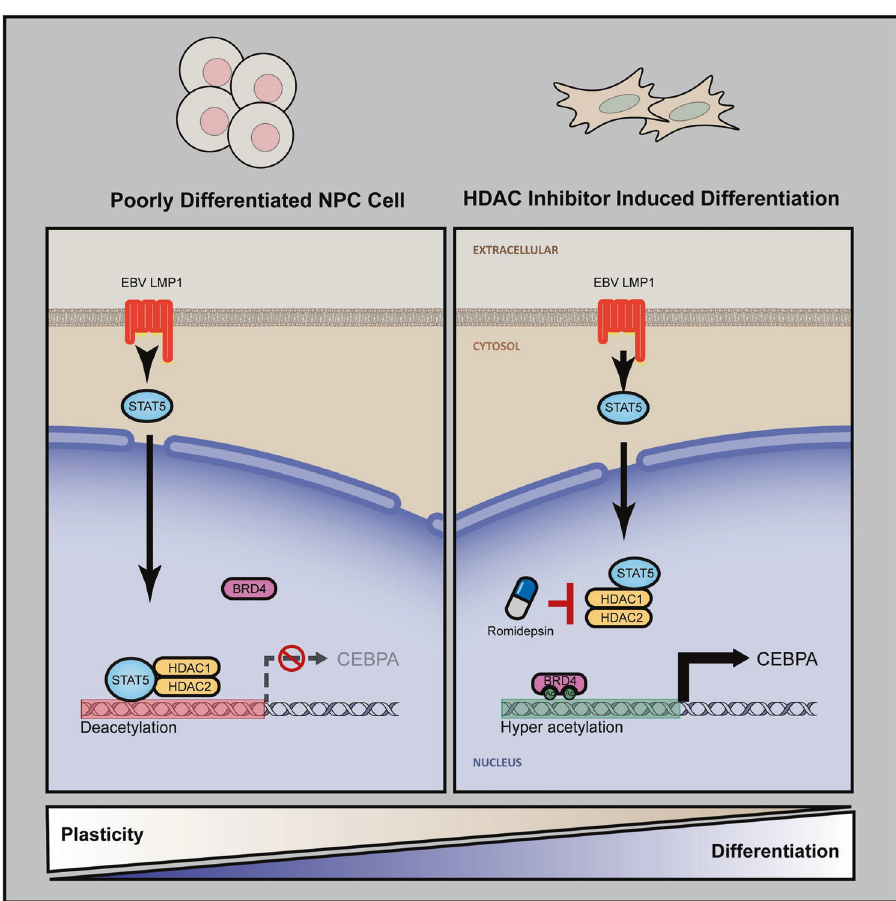
Fig. 9 Model depicting the mechanism by which the HDAC inhibition reverses LMP1 suppressed differentiation in NPC